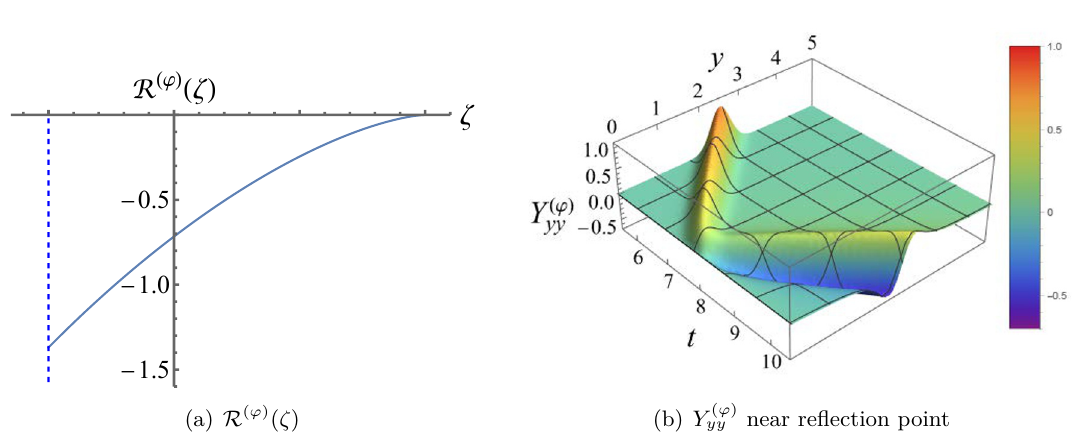
Figure 4 . Numerical solution for d = 3 , m 2 = 0 , k = 0 , λ ρ = 5 / 4 and initial wave packet with y 0 = 4 , s = 1 / 8 . In panel (a), only a part of the numerical domain for 0 < t < 12 is shown. Panel (b) shows the solution near the reflection point ( t, y ) ’ (8 , 0) .